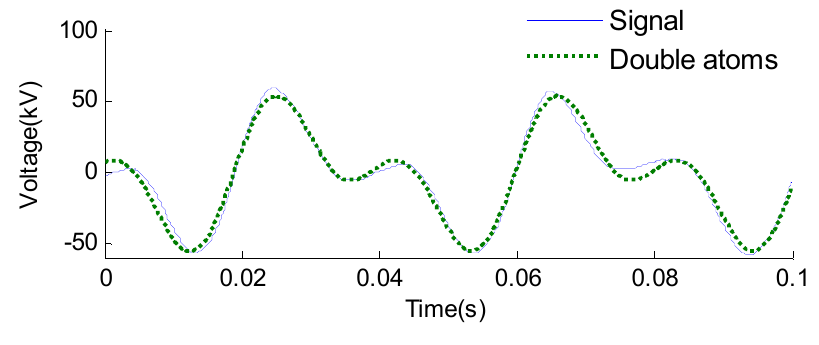
Figure 7. Double-atom decomposition result of sub-frequency